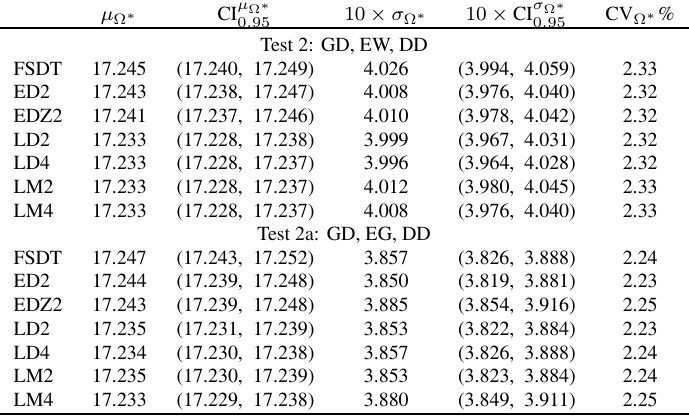
Ω ∗ statistic estimators in the case of the anti-symmetric laminate, fi rst material and a 0 /h 0 = 100.